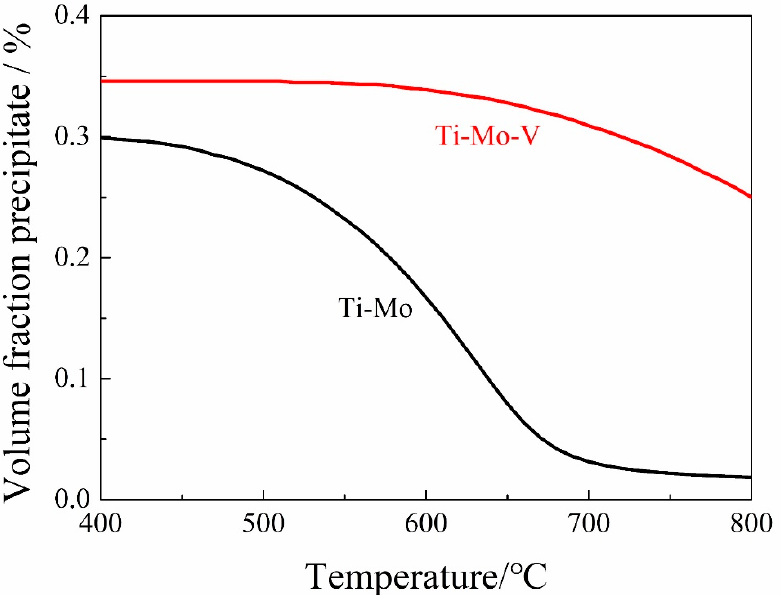
Figure 9. Volume fractions of precipitation in Ti − Mo and Ti − Mo − V steels as a function of tempera- ture in ferrite.